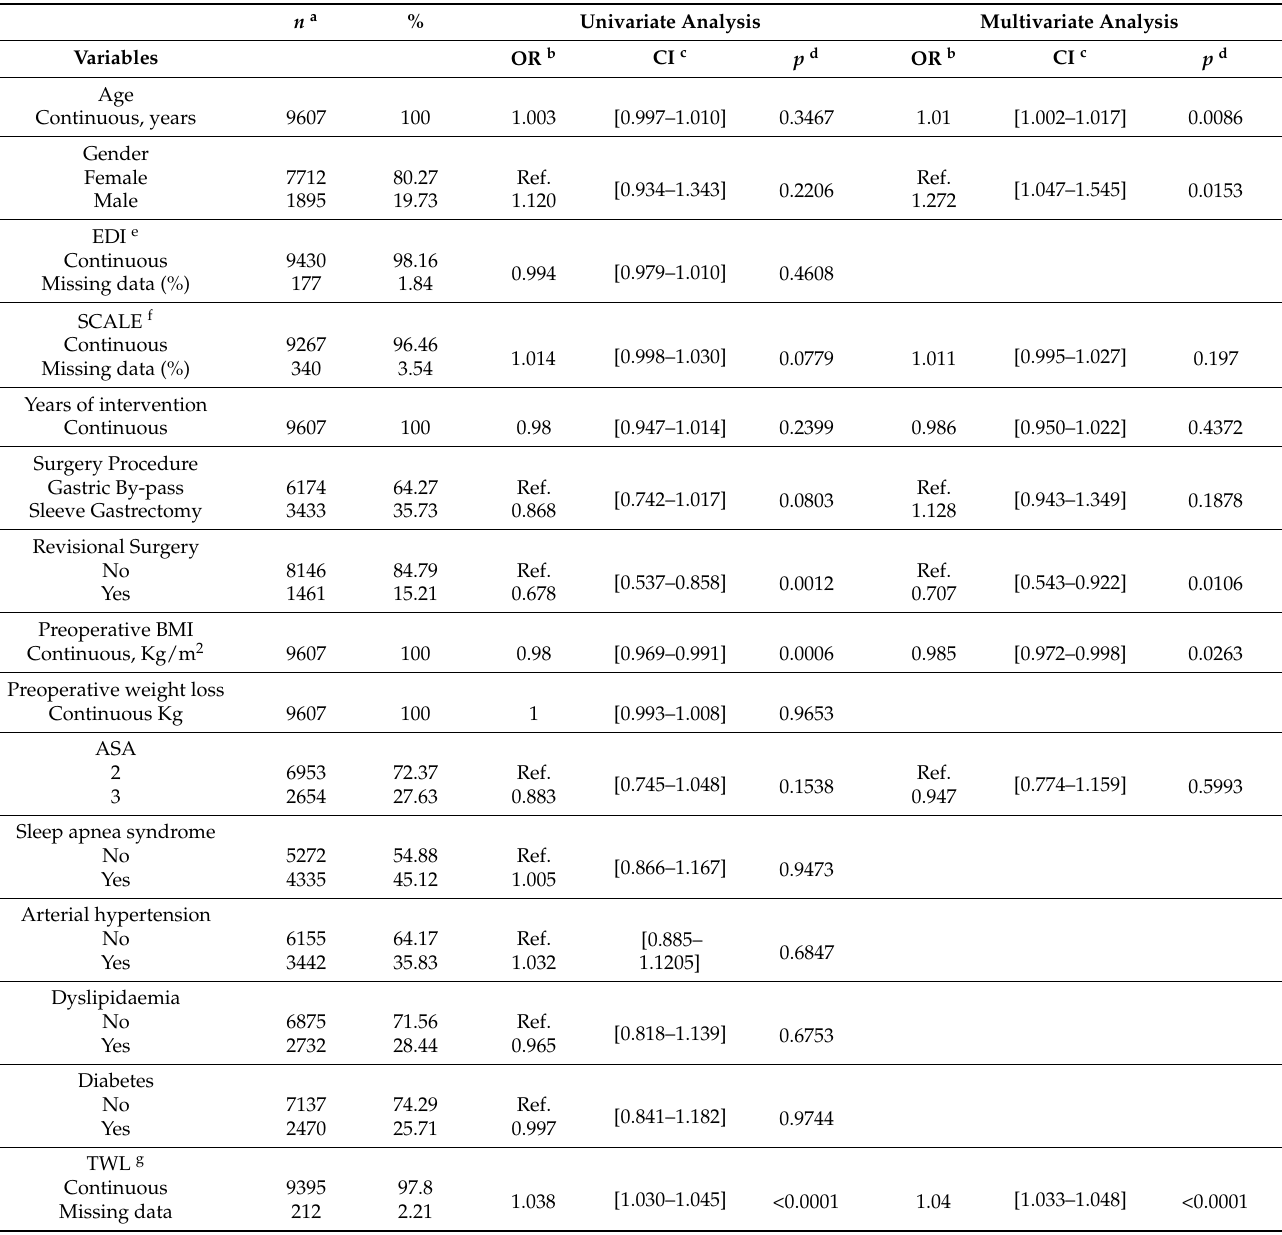
Table A5. Multilevel logistic regression model for the probability of having an irregular